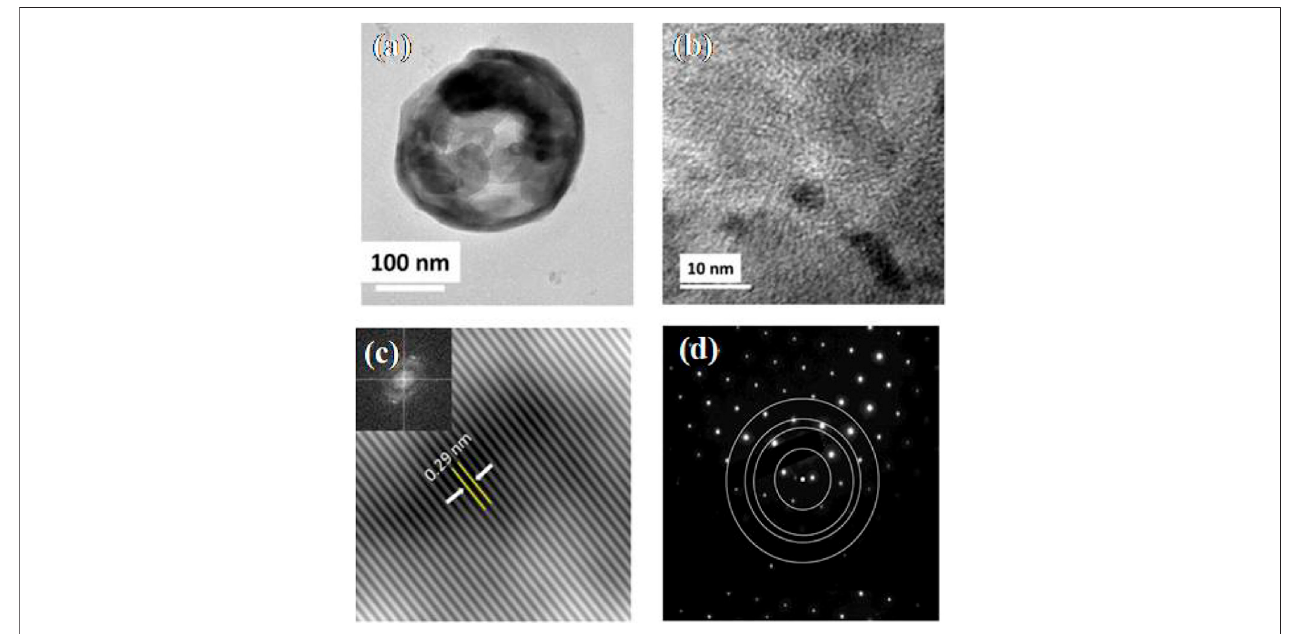
FIGURE 5 | Field-emission transmission electron microscopic image of (A) BZO hollow nanospheres and (B) high-resolution transmission electron microscopic imageofBZOhollowspheres.Theinsetto (C) isthefastFouriertransformedimageofthehighlightedportioninimage (B) , (C) showstheinversefastFouriertransformed imageofthemaskedfastFouriertransformedimageshownintheinsetto (C) , (D) showstheselectedareaelectrondispersionpatternsofBZO.(ReproducedfromPatra et al., 2018, American Chemical Society).